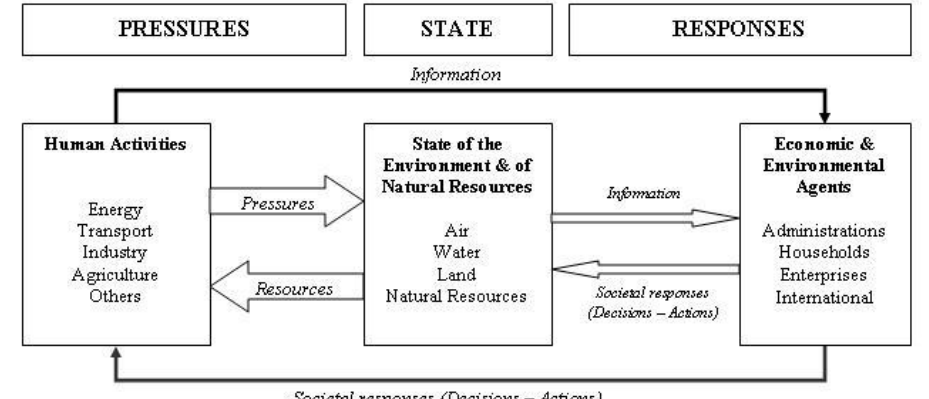
Figure 1. Pressure-State-Response framework (reproduced with permission from [33], published by OECD, 1993). Human activities exert pressures on the environment and change its quality and the quantity of natural resources (―State‖ box). Society responds to these changes through environmental, economic, and sectoral policies (―Societal responses‖) intended to prevent, reduce, or mitigate pressures, and/or environmental damage. Social responses form a feedback loop to pressures through human